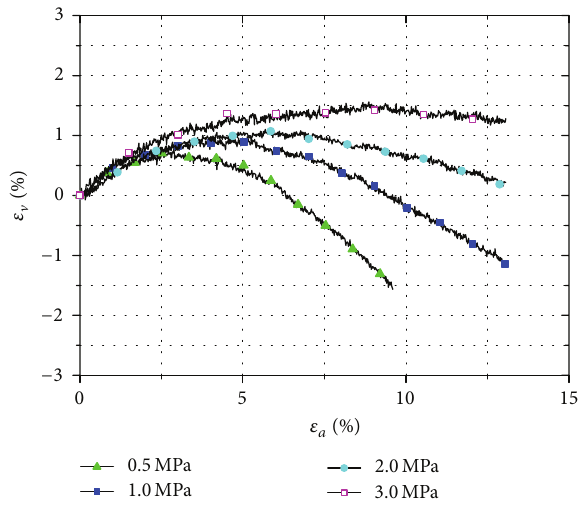
Figure 1: The stress-strain curves of frozen silt at − 8 ∘ C.